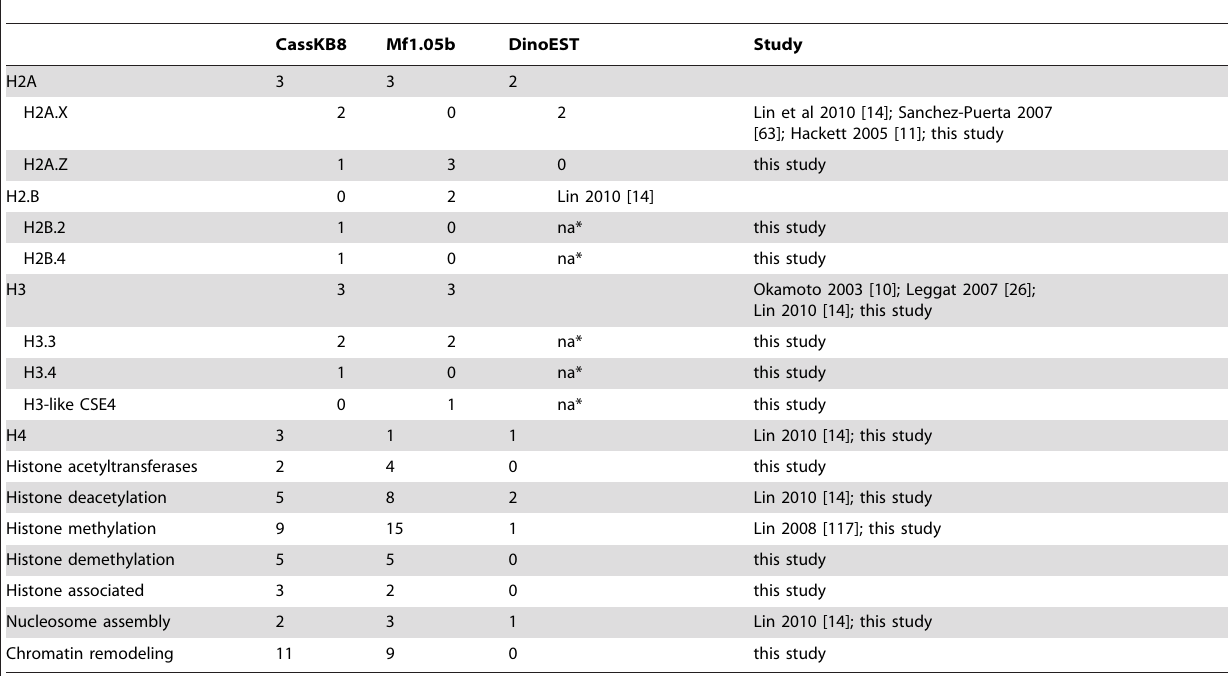
Table 5. Comparison of histones and nucleosome-associated proteins from this and previous studies (DinoEST).